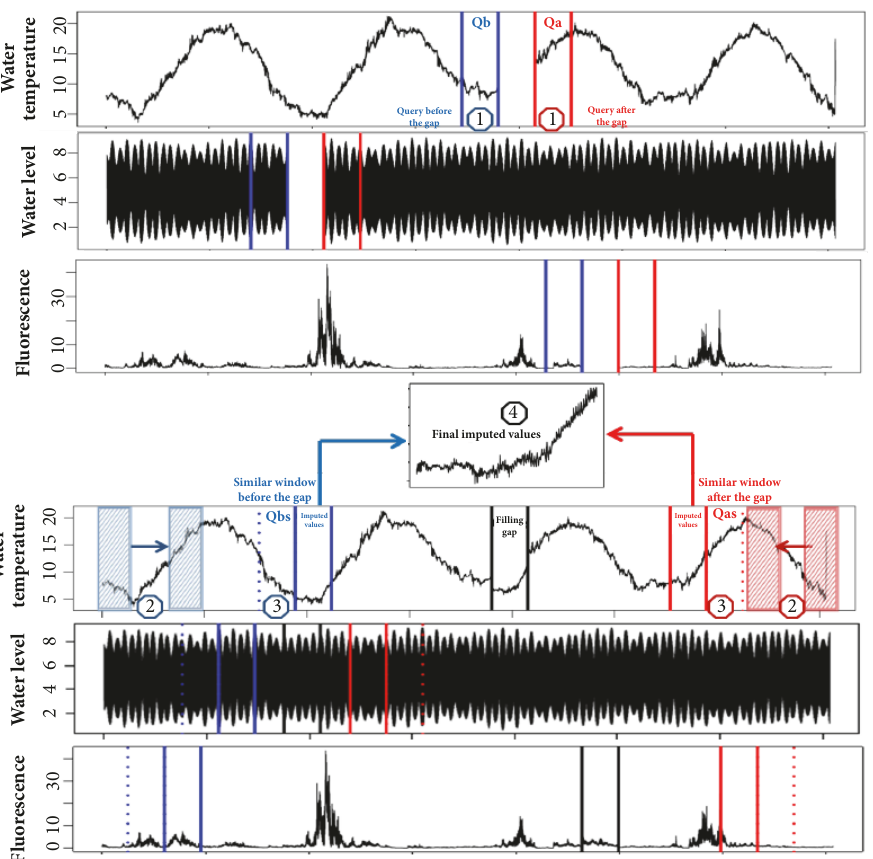
Figure 3: Scheme of the completion process: (1) building queries, (2) comparing sliding windows, (3) selecting the most similar windows, and (4) completing